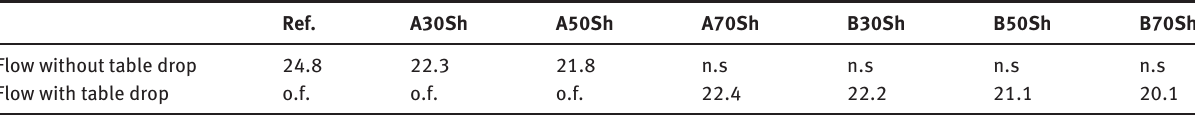
Table 2: Flow test results.